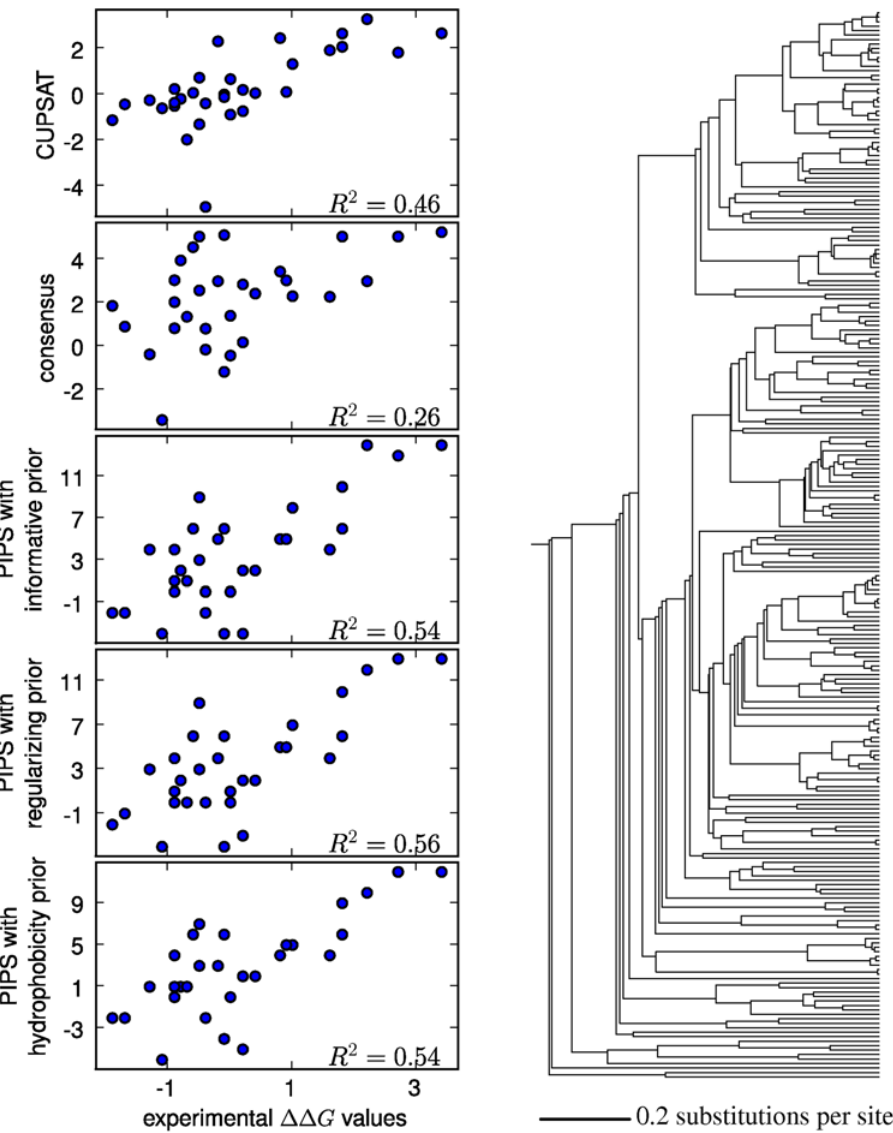
Figure 6. Experimentally measured and predicted DD G values for the 156-residue ribonuclease HI protein. The plots at left show the predictions made by the CUPSAT physicochemical modeling program, the consensus approach, and the PIPS phylogenetic inference program using the informative, regularizing, and hydrophobicity priors. To the right is the phylogenetic tree of 239 sequences that was utilized by the PIPS program. The R 2 values are the squared Pearson correlation